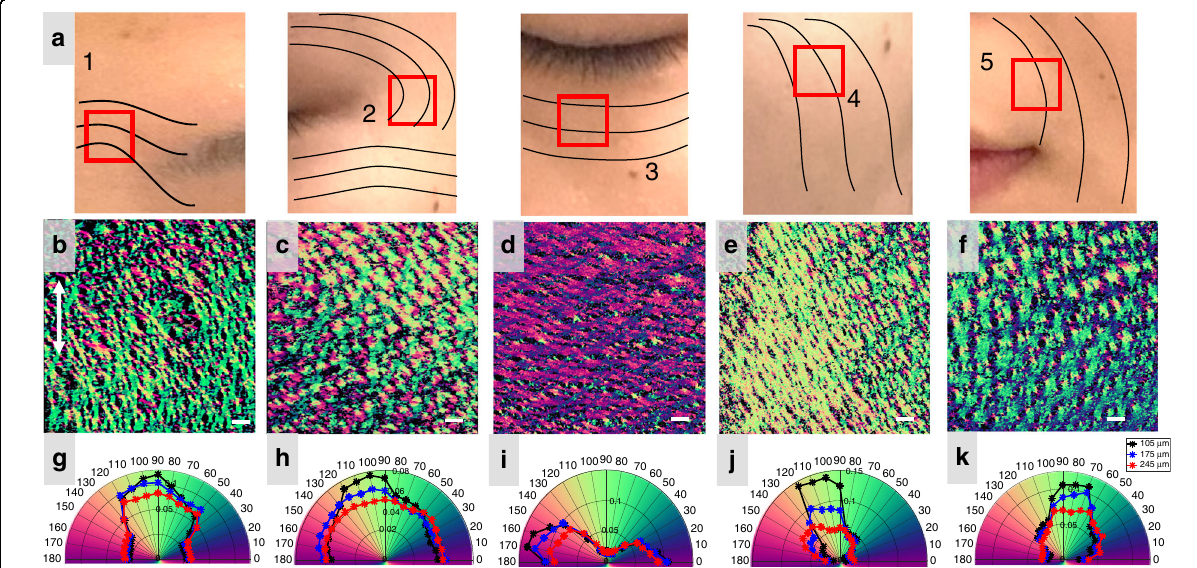
Fig. 3 Collagen organizations at various locations on the human facial skin. With the DDG-based PST method, PSOCT reveals macroscopic architecture of collagen organizations at various locations on the human facial skin. a Illustration of selected regions (marked as red squares, 1 – 5) on the human facial skin for representative PSOCT imaging of the relaxed skin tension lines (RSTLs), where 1 – 5, respectively indicate the facial regions of glabella, lateral eyelid, inferior eyelid, cheek, and upper lip. b – f The en-face axis orientation (OAx) PSOCT images (generated by average projection of a 70 μ m slab, starting from approximately 105 – 175 μ m depth from the skin surface) acquired from the regions of b glabella; c Lateral eyelid; d Inferior eyelid; e cheek; f upper lip. g – k The corresponding histogram distributions of orientation obtained from the en-face OAx slices measured at g glabella; h lateral eyelid; i inferior eyelid; j eye bag; k upper lip, respectively, at three different depths (105 μ m, 175 μ m and 245 μ m). White double- headed arrow in (B) shows the direction of the body axis. The yellow arrow indicates the B-scan direction, which is de fi ned as the 0°. The scale bar = 500 μ